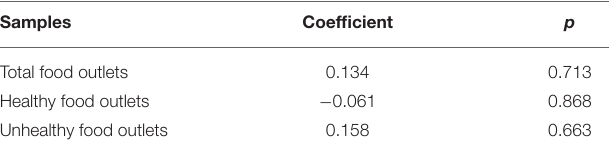
TABLE 3 | Spearman’s correlation test between results of food environment measured by the counting method and TUHII, HII, and UHII in different